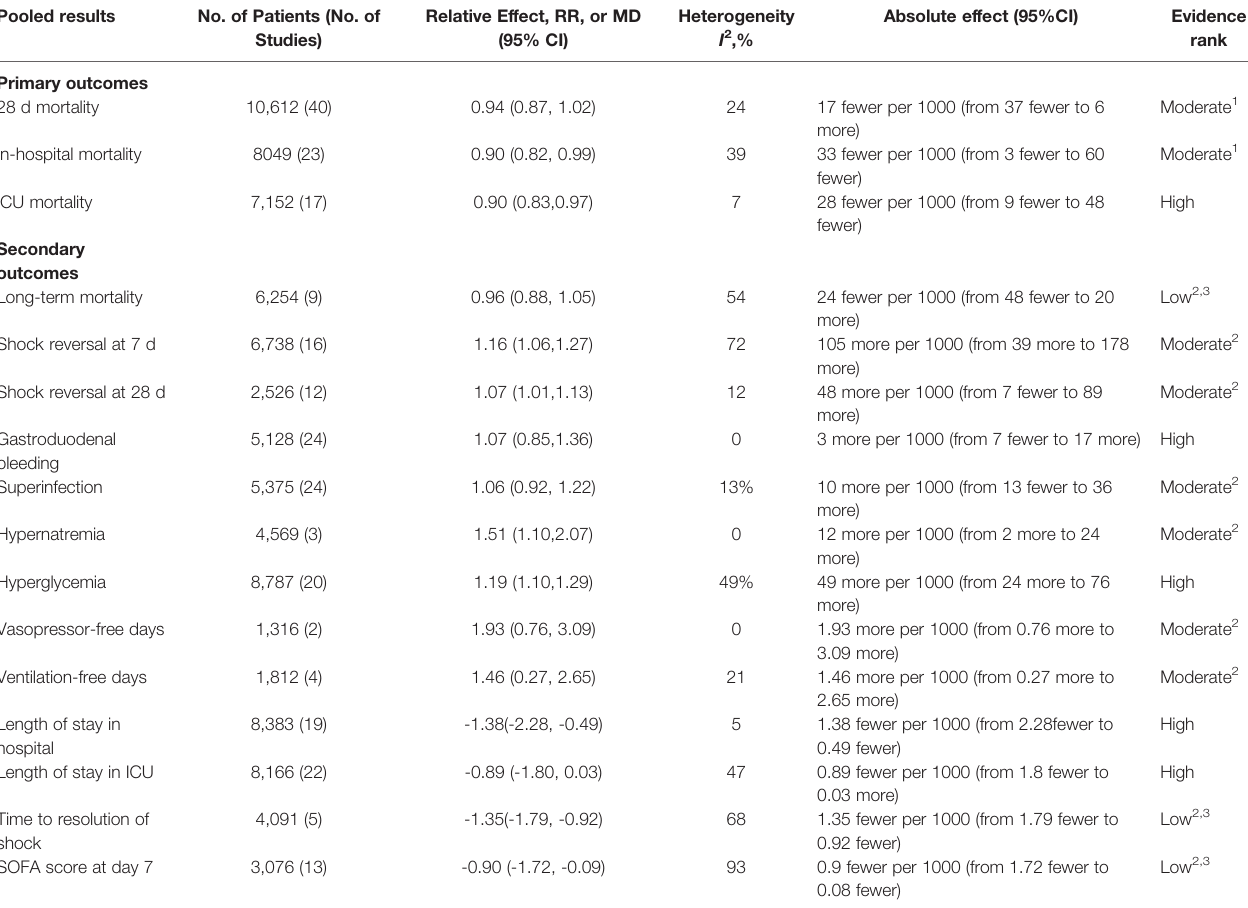
TABLE 2 | The fi ndings and evidence rank of the included studies in patients with